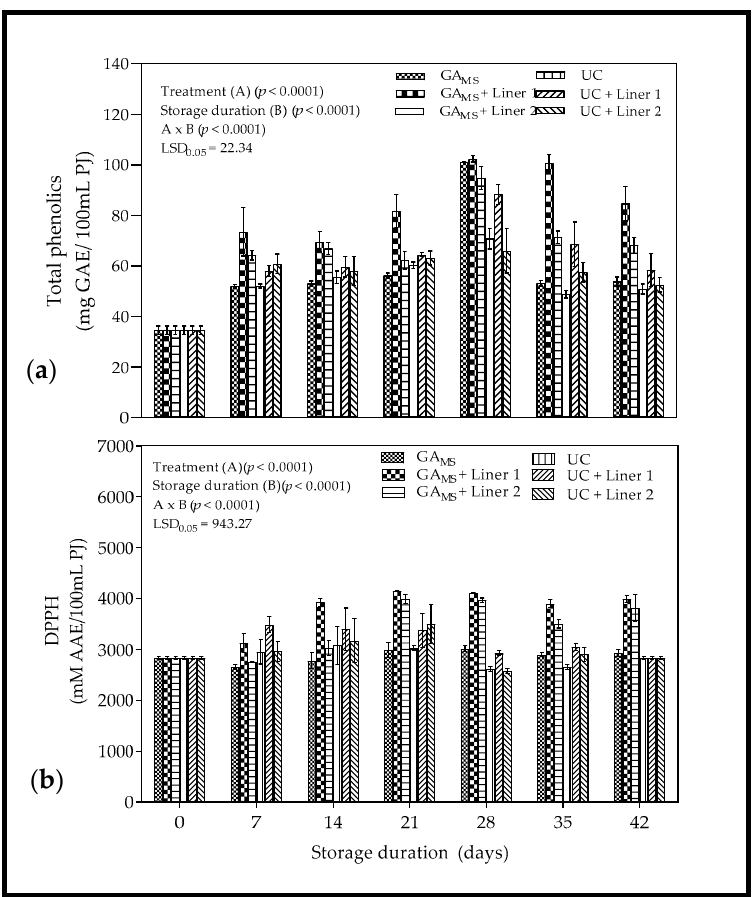
Figure 8. ( a ) Total phenolic content (mg GAE/100 mL PJ) and ( b ) radical scavenging activity (mM AAE/100 mL PJ) of ‘Wonderful’ pomegranate coated and packaged in different polyliners and stored (5 ± 1 °C, 95 ± 2% RH) for 42 d. GA MS —gum Arabic (0.5% w / v ) and maize starch (0.5% w / v ); Liner 1—Xtend ® liner (20 µmm perforations); Liner 2-perforated liner (4 mm perforations); UC— uncoated fruit. LSD 0.05 represents least significant difference ( p < 0.05).